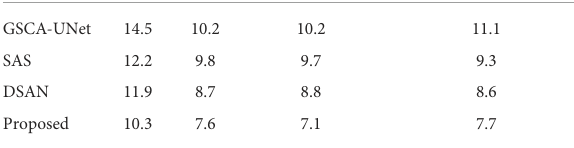
TABLE 4 The average detection time with different methods.